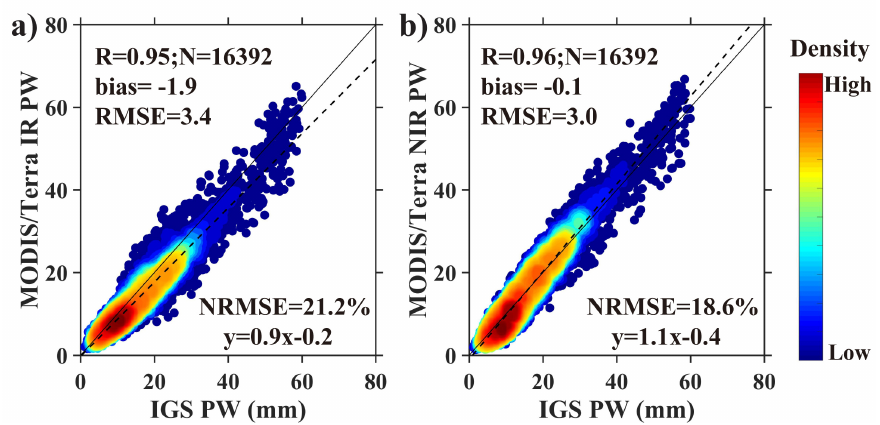
Figure 2. Comparison of the elevation corrected IGS PW with ( a ) MODIS IR PW and ( b ) MODIS NIR